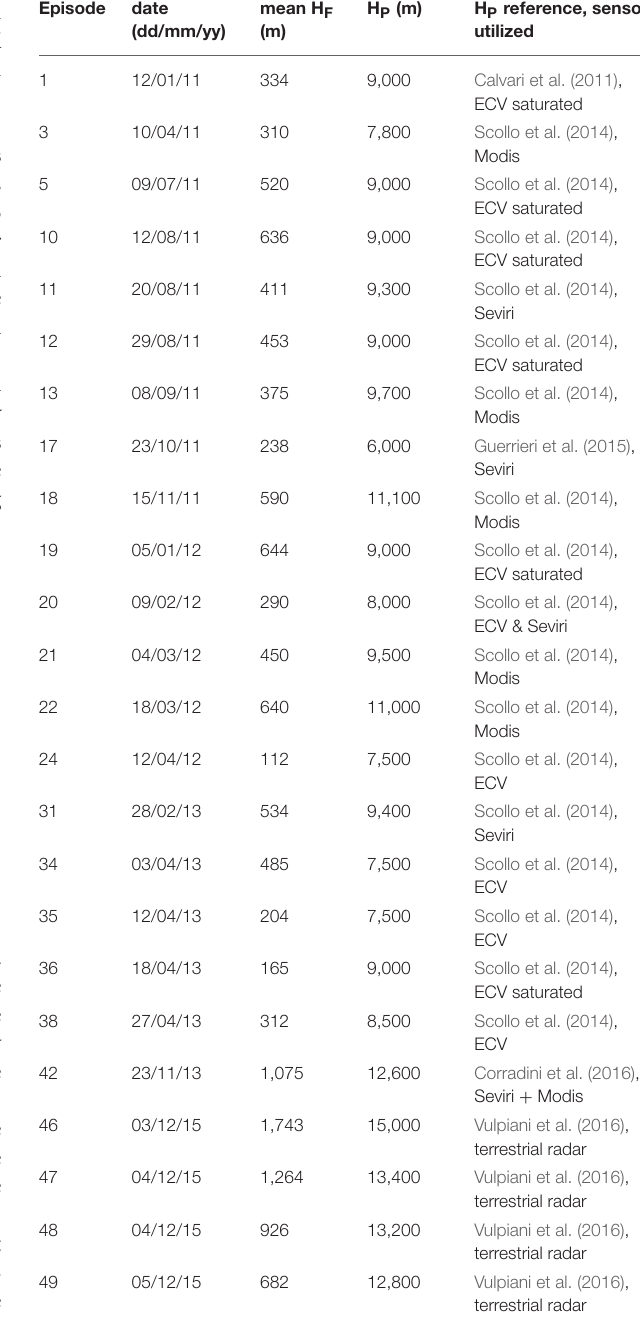
TABLE 4 | Episodes (first column) and dates (second column) of lava fountains of NSEC (events from 1 to 42) and VOR (events from 46 to 49) with the mean height of the fountains (H F ) as obtained from the cam analysis in this study (third column) and maximum height of the plume (H P ) (fourth column) as reported in literature with the sensor utilized (fifth